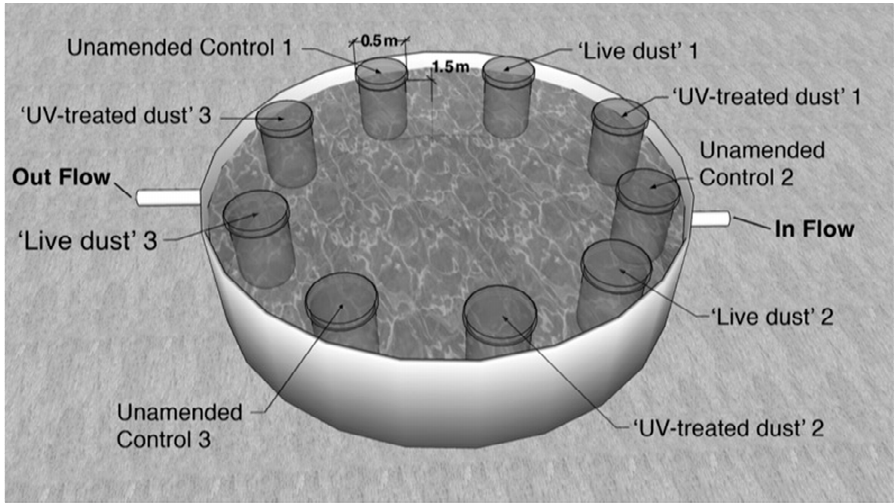
Figure 1. An illustration of the experimental mesocosm used in this study. Treatments included unamended controls, live dust and UV-treated dust run in triplicate 300 L transparent bags.